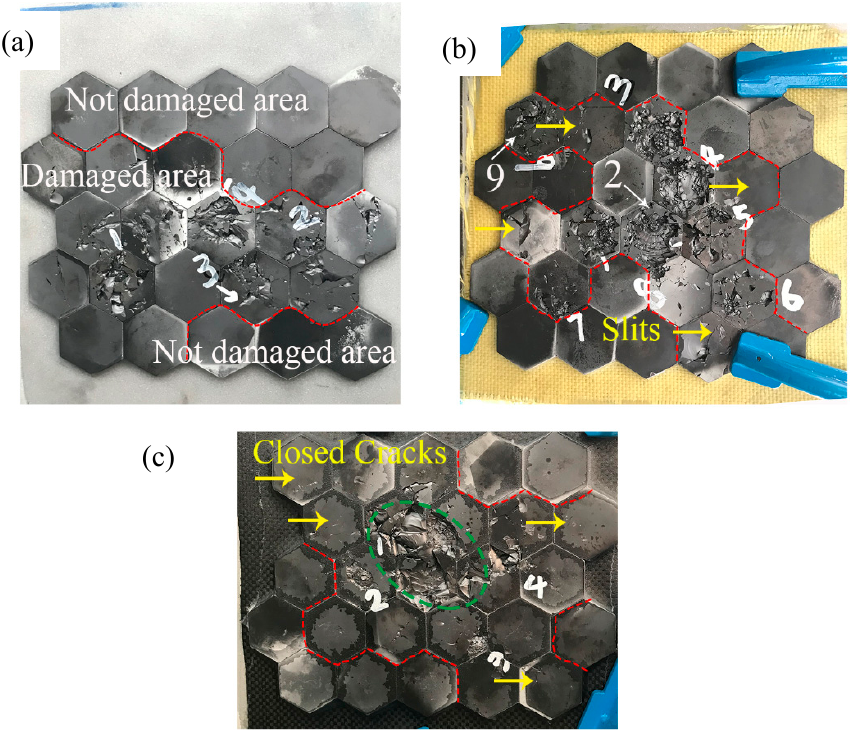
Figure 6. Final ceramic damage morphology of the three structures: ( a ) Structure 1; ( b ) Structure 2; ( c ) Structure 3.